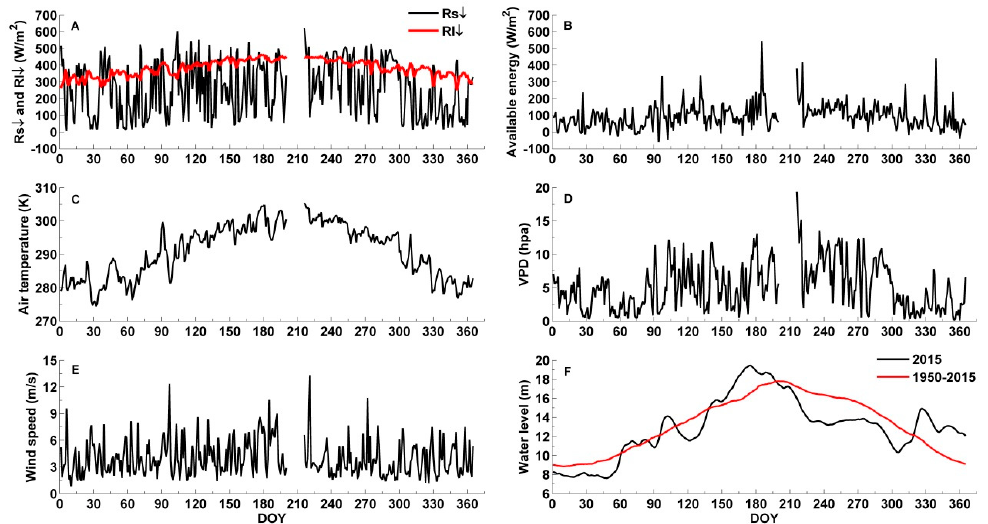
Figure 3. A–E are seasonal variations in meteorological variables, including the incoming shortwave and longwave radiation ( A ), the available energy ( B ), air temperature ( C ), VPD ( D ), and wind speed ( E ). Water level variations at Xingzi station are shown in ( F) , where black and red lines represent the daily values in 2015 and the averaged daily values during the period of 1950–2015, respectively.